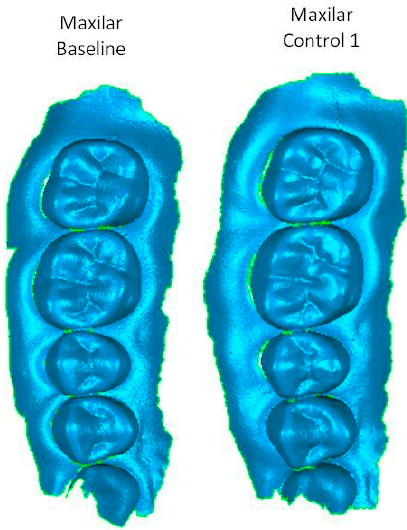
Figure 2. Control images.